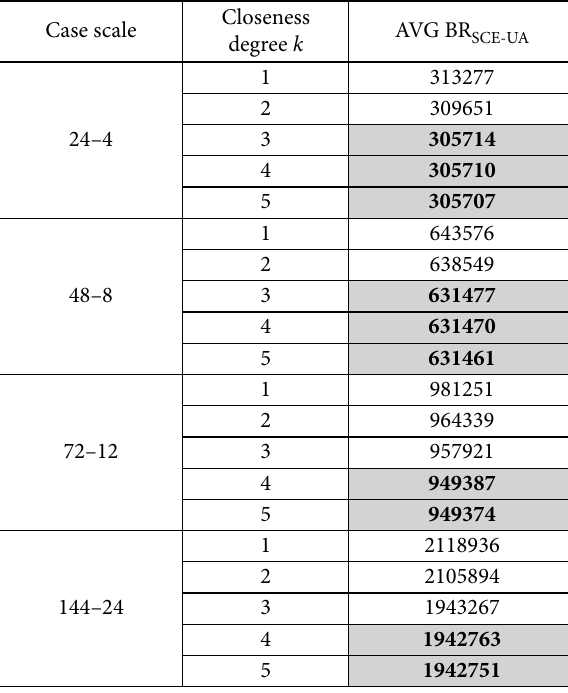
Table 5. Results of cases with different closeness degree